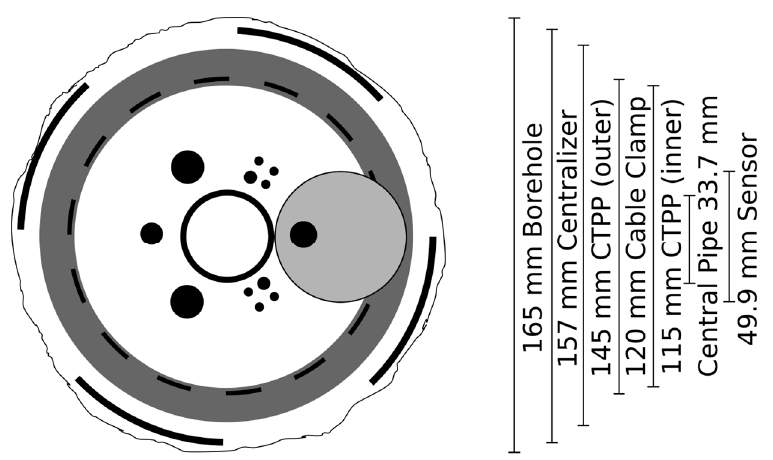
Figure 3. Illustration showing the limited space inside the borehole (crosscut). The sketch shows the geometries of the most dominant devices installed in the BRP project with respect to the borehole diameter (most outside thin black line): the solid lines show the outer diameter of the centralizer springs; the dashed line shows the diameter of the cable clamps; the dark grey ring shows the cementable tube pore pressure; the bright grey circle shows the largest sensor installed next to the central rod (accelerometer); the solid black line in the center shows the central tubing; and the solid black circles show the different cables. All devices are separated in space to improve consistent cementation. Details in text.